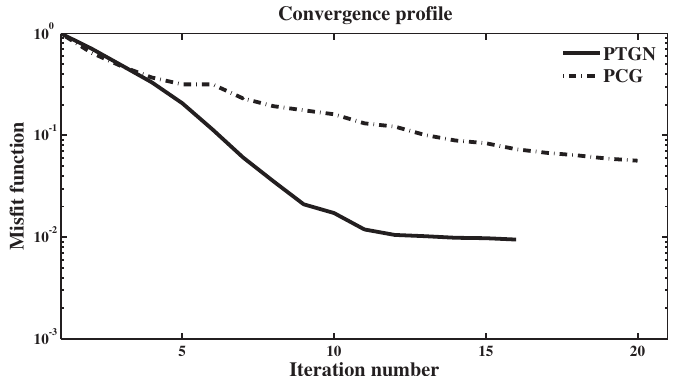
Figure 10. Convergence profiles of the misfit function using PTGN (solid) and PCG (dashed).